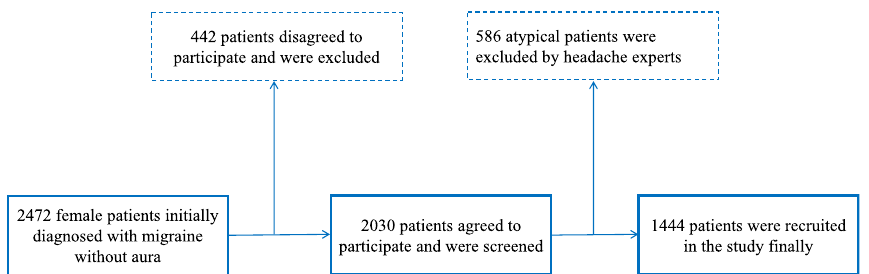
Fig. 2 Flow chart of recruitment. There were 1444 female patients with migraine without aura participating in the study. The chart shows the screening